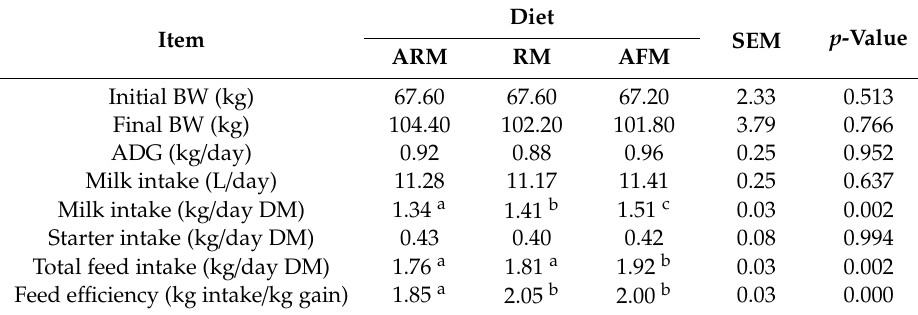
Table 4. Growth performance of dairy calves fed di ff erent types of milk.